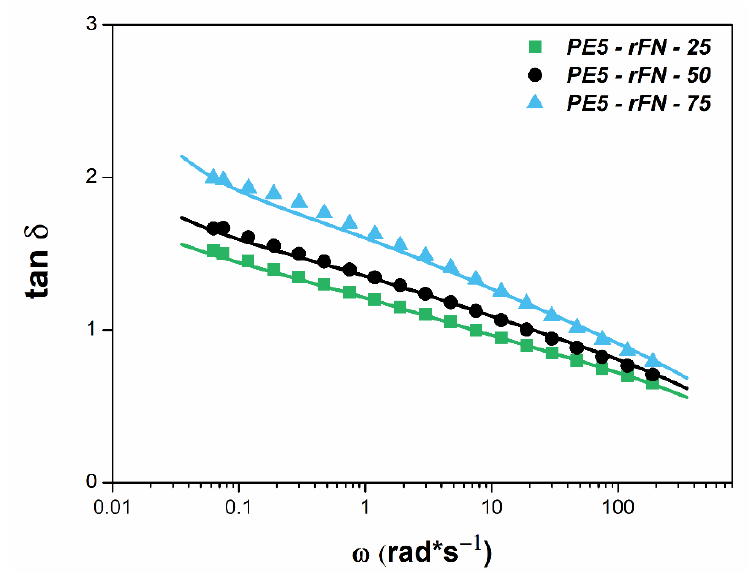
Figure 8. Tan δ versus the angular frequency for PE5—rFN system at 190 °C. Solid lines represent the results of the additive model for miscible blends.